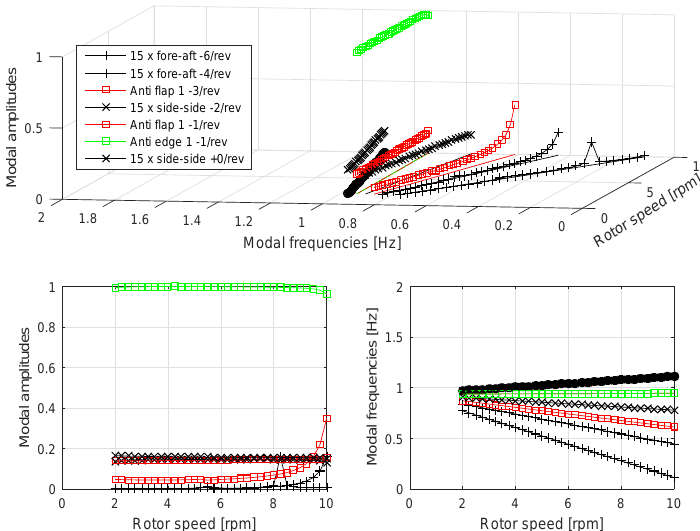
Figure 20. Harmonic modal components for the two-bladed turbine mode dominated by antisymmetric deflection of the rotor in the edgewise DOF. Plot layout as in Fig. 5.